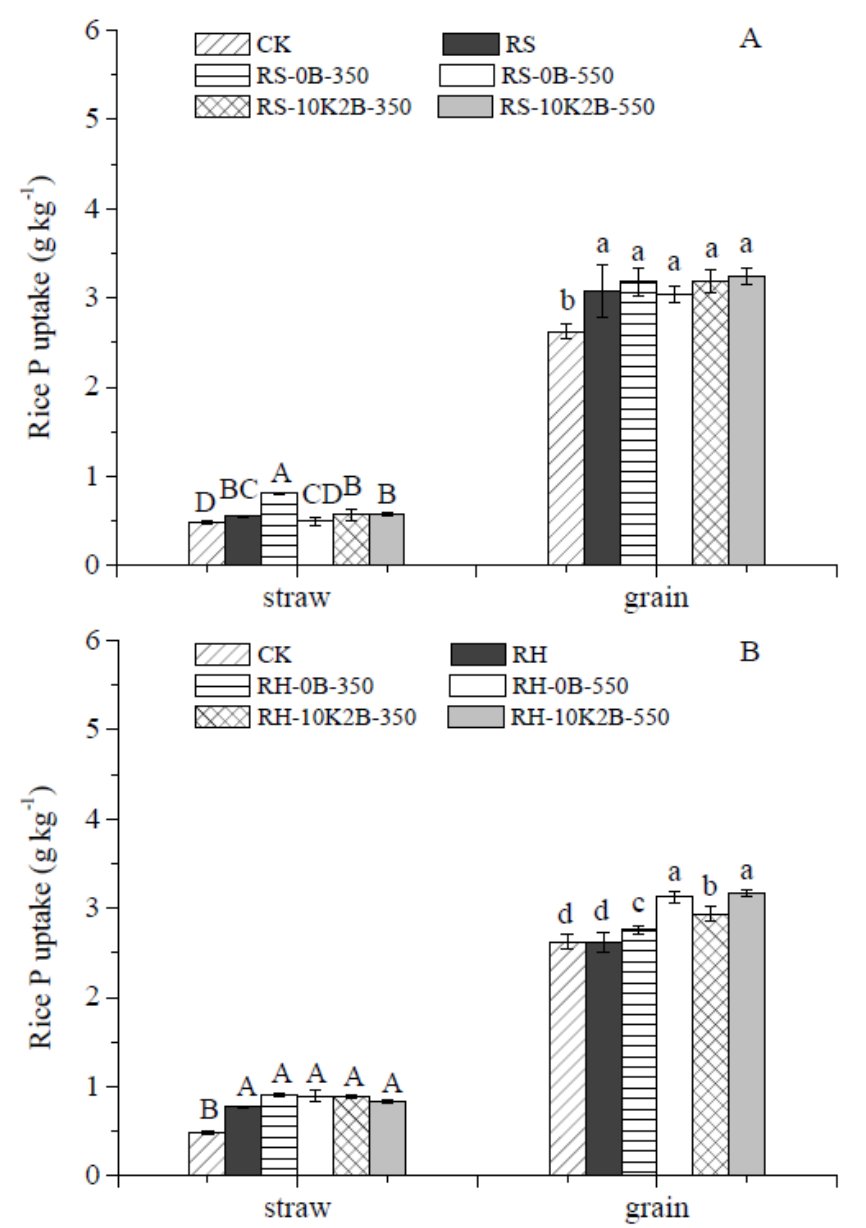
Figure 5. Rice P uptake with alkali-enhanced ( A ) rice straw and ( B ) husk biochar amendment. Note: CK, non-amendment; RS, rice straw; RH, rice husk; RS/RH-0B-350 and RS/RH-10K2B-350 are rice straw/husk biochars prepared with the proportion of K 2 CO 3 to feedstock at 0 and 10 at 350 ◦ C, respectively; RS/RH-0B-550 and RS/RH-10K2B-550 are rice straw/husk biochars prepared with the proportion of K 2 CO 3 to feedstock at 0 and 10 at 550 ◦ C, respectively. Different letters indicate significant differences within treatment ( p < 0.05) based on Duncan’s multiple range test.